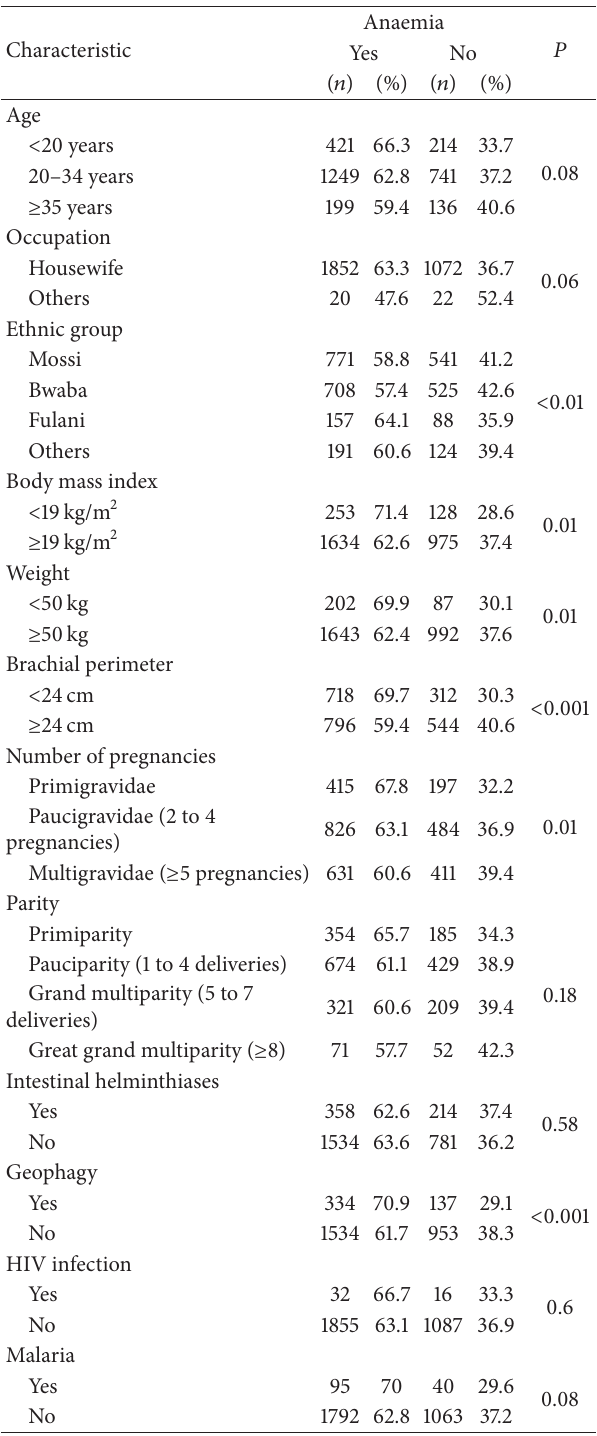
Table 3: Factors associated with maternal anaemia in Hound´e health district, Burkina Faso, univariable